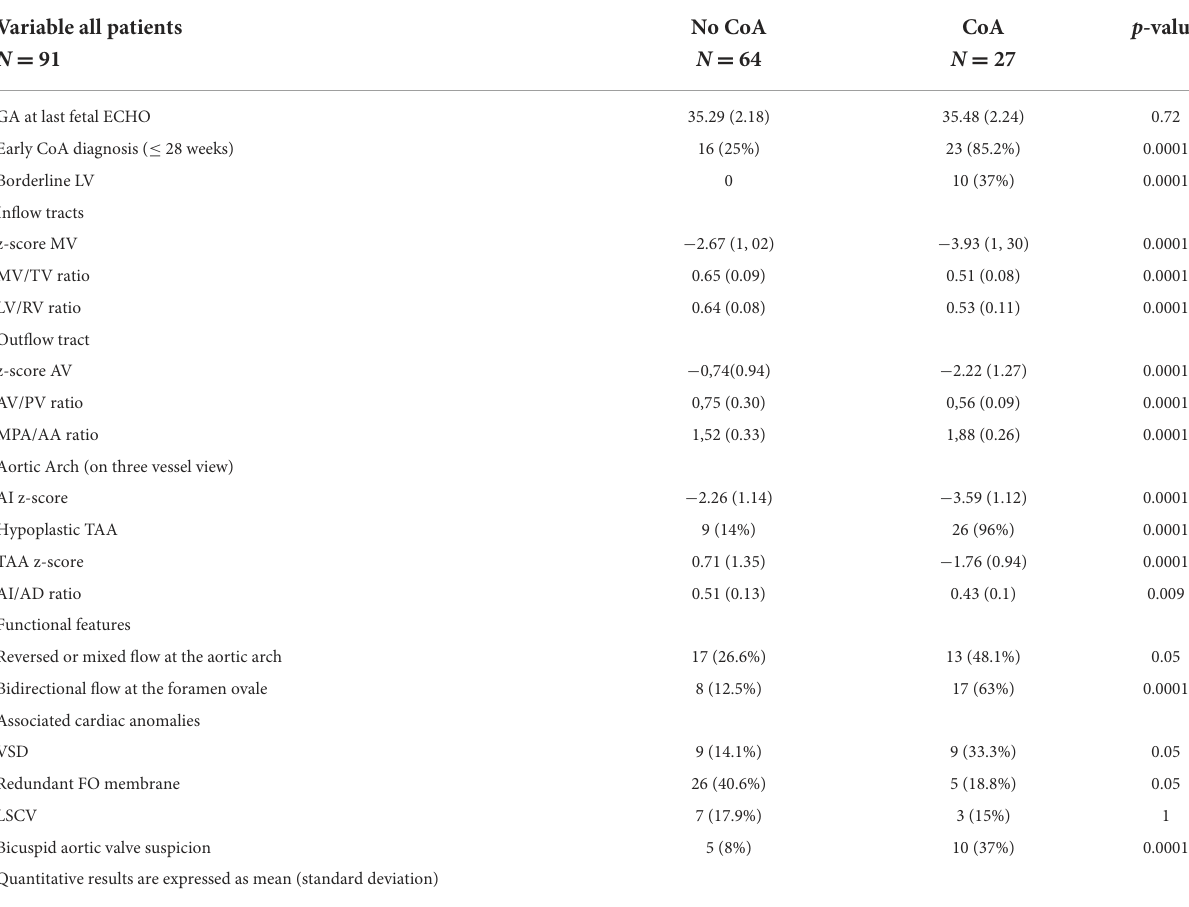
TABLE 2 Prenatal ultrasound findings of the study population (fetuses with suspected CoA), according to postnatal outcomes (neonates normal and with CoA). Variable all